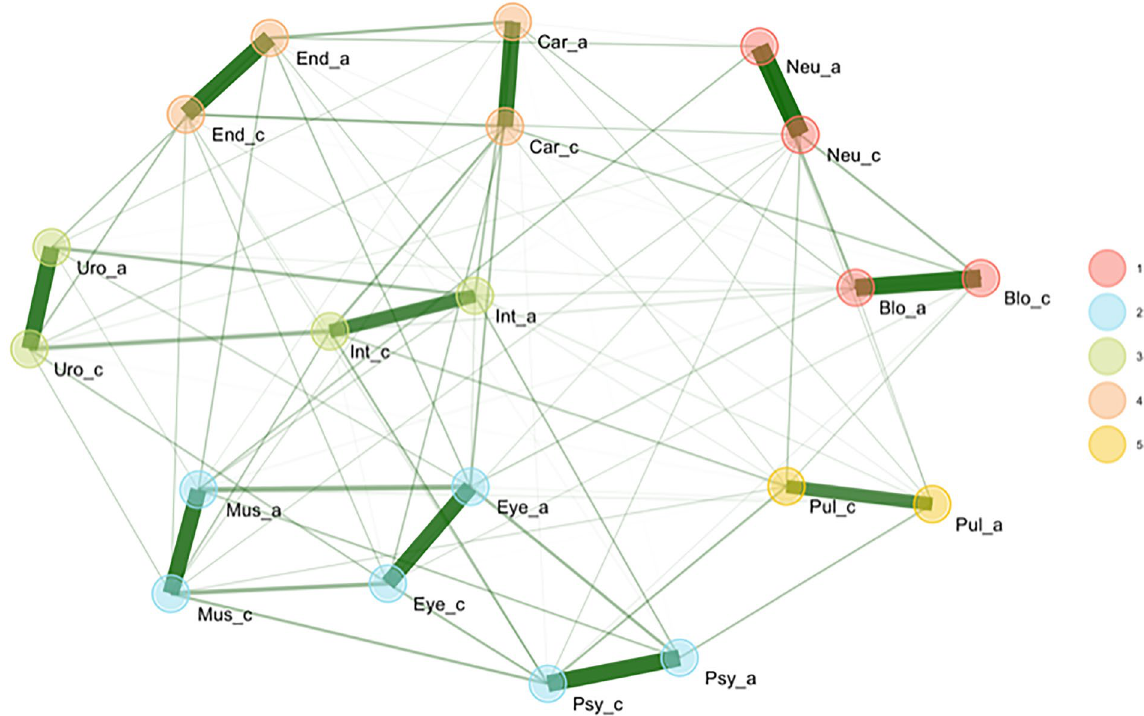
Figure 4. Co-occurrence and clusters (1–5) of acute and chronic health problems in the ten body regions under investigation (_a = acute, _c = chronic, Car = cardiac, End = endocrine, Pul = pulmonary, Uro = urogenital, Int = gastrointestinal, Blo = blood, Eye = eye/ear, Mus = musculoskeletal, Neu = neurological, Psy = mental/